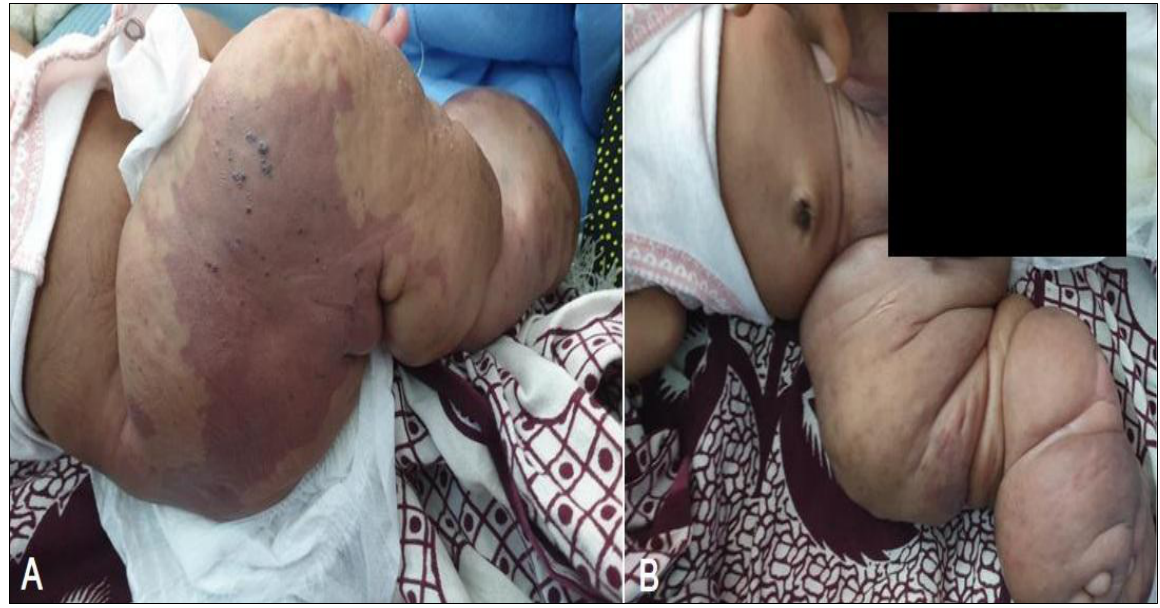
Figure 1: A & B) Photographs showing right lower limb edema with a pink-red patch on the lateral thigh.